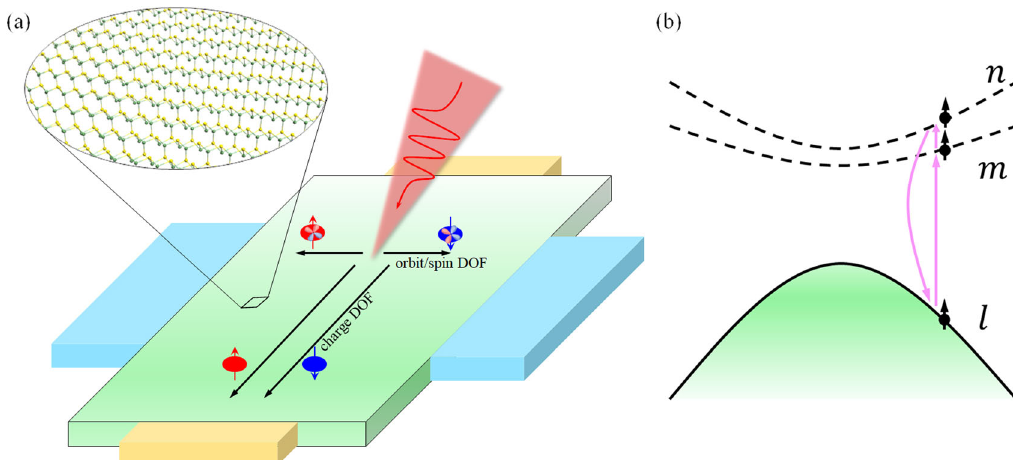
Fig. 1 Bulk photovoltaic effect and microscopic picture. a Schematic plot of bulk angular momentum photoconductivity (BOPV and BSPV) effect. Unlike BPV that propagates along the mirror plane of monolayer GeS, the BOPV and BSPV currents carrying orbital and spin DOF information are traveling normal to the mirror plane ( M x ) under light. A four-terminal device can be used to detect all these photocurrents. The yellow electrode measures charge DOF, while the blue electrodes are magnetic and could measure angular momentum DOF. b Interband transition (pink arrows) picture, where black arrows indicate angular momentum or magnetic moment from orbital and spin DOF. Solid and dashed curves represent occupied (valence) and unoccupied (conduction) bands of the semiconductor,